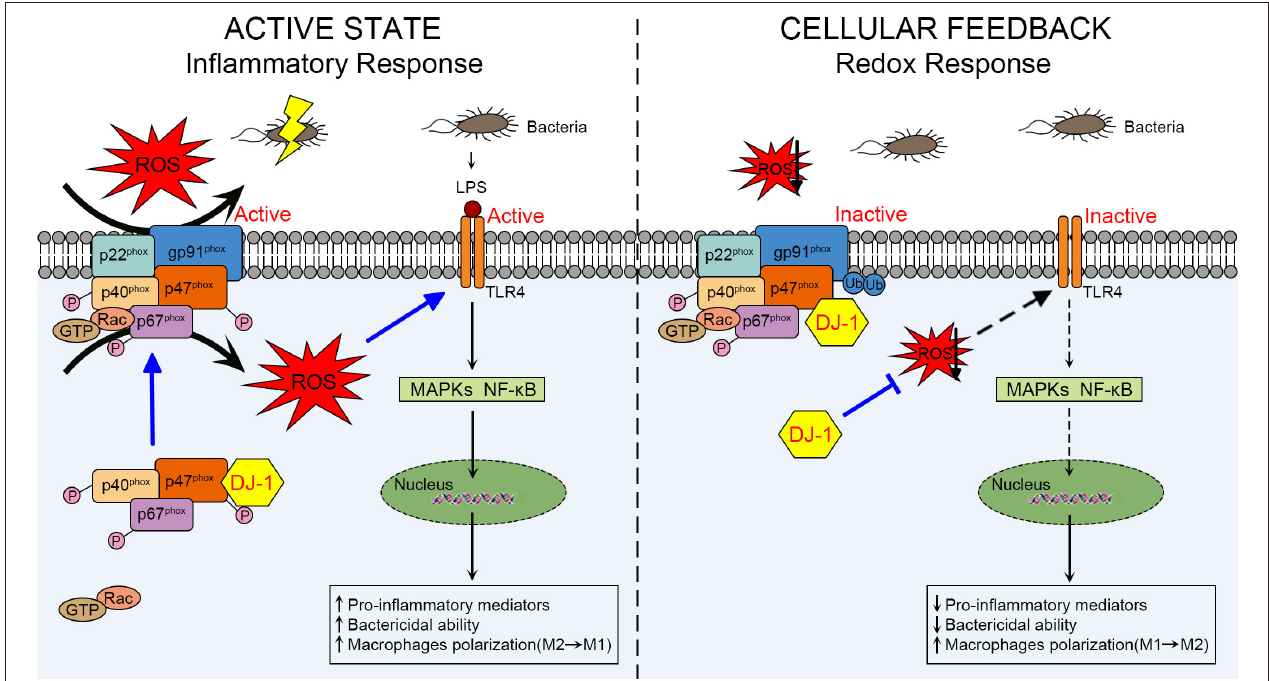
FIGURE 2 | Schematic diagram of the role of DJ-1 in regulating macrophage activation through NOX-dependent ROS production and TLR4 signaling pathways during sepsis. In the active state of macrophages, DJ-1 probably exerts a protective function against LPS-induced sepsis. Through direct interaction with p47 phox , DJ-1 promotes NOX-dependent ROS production, which facilitates TLR4/MAPKs and/or TLR4/NF- κ B signaling pathways and results in releasing pro-inflammatory mediators, killing bacteria and polarizing to M1 phenotype. However, available DJ-1 functions as an antioxidant in cellular negative feedback to protect from oxidative stress and excessive inflammatory response. DJ-1 can reduce ROS at least through binding to p47 phox , disrupting NOX stability and its ROS generating capacity, thereby impairing TLR4 activation and downstream signaling pathways. NOX, NADPH oxidase; TLR4, Toll-like receptor 4; LPS, lipopolysaccharide; MAPKs, mitogen-activated protein